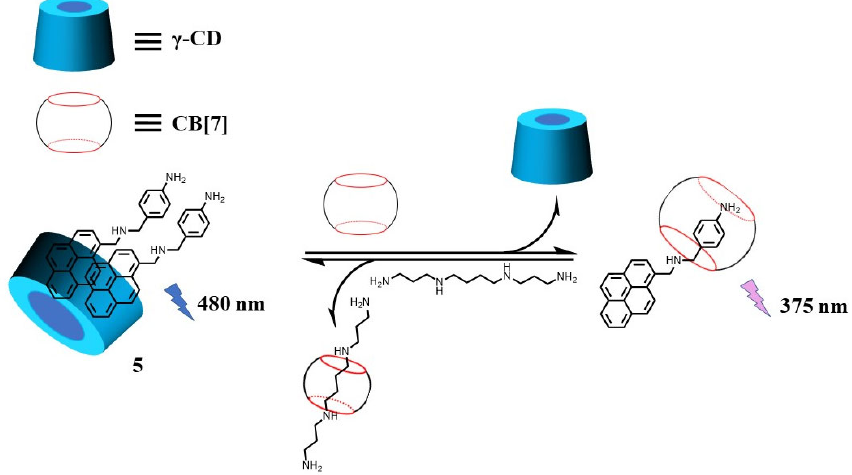
Figure 6. Competitive/synergetic complexation among CB[7], γ‐ CD, spermine and pyrene [51].